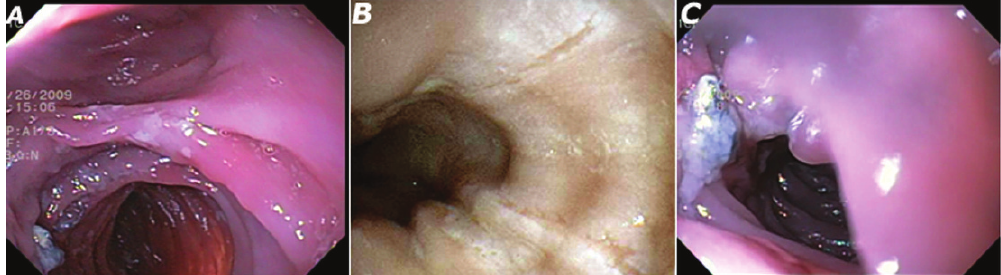
Figure 2 - Pre - and intraoperative endoscopic view during laparoscopic fundoplication post-RYGB for obesity. A– Patent GJ. Transillumination of the jejunum with the laparoscope can be observed. B - Grade B Los Angeles reflux esophagitis (10-mm longitudinal mucosal breaks). C – Erosion in the pouch near the GJ. Abbreviation: GJ –